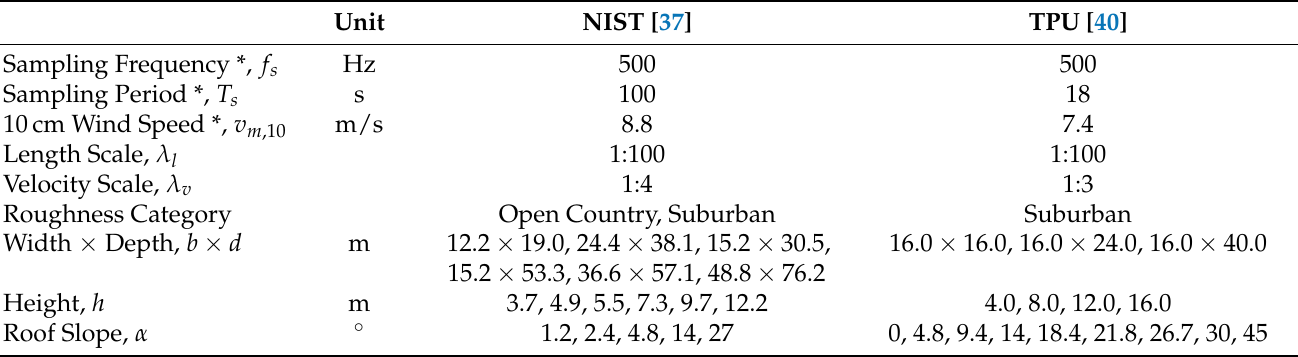
Table 2. Main aerodynamic databases for isolated low-rise